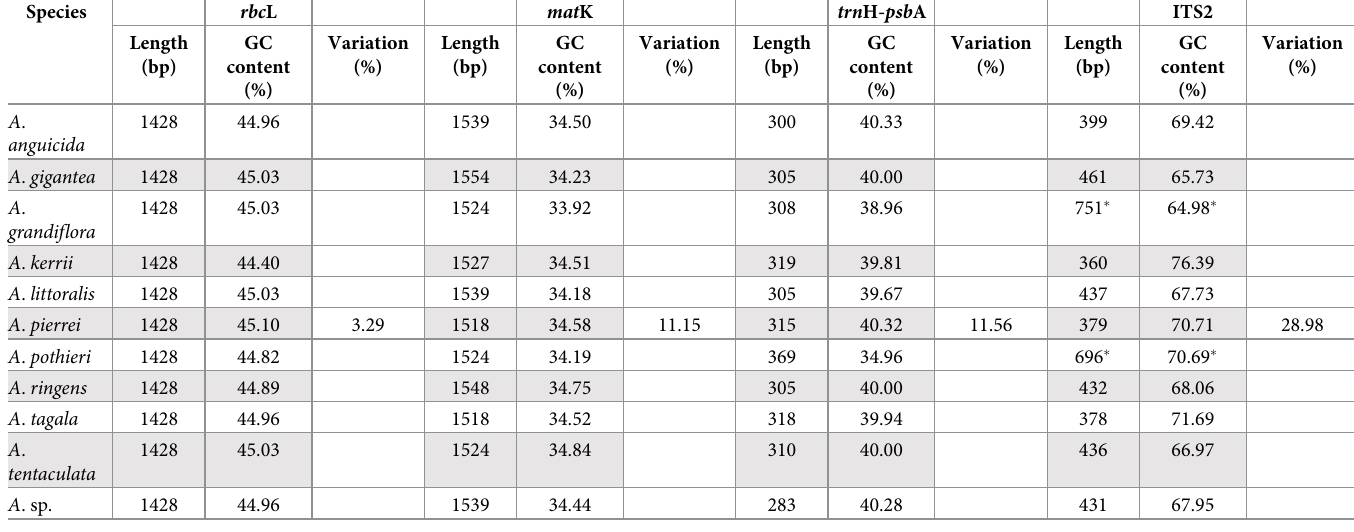
Table 4. Properties of the four DNA barcoding regions of Aristolochia